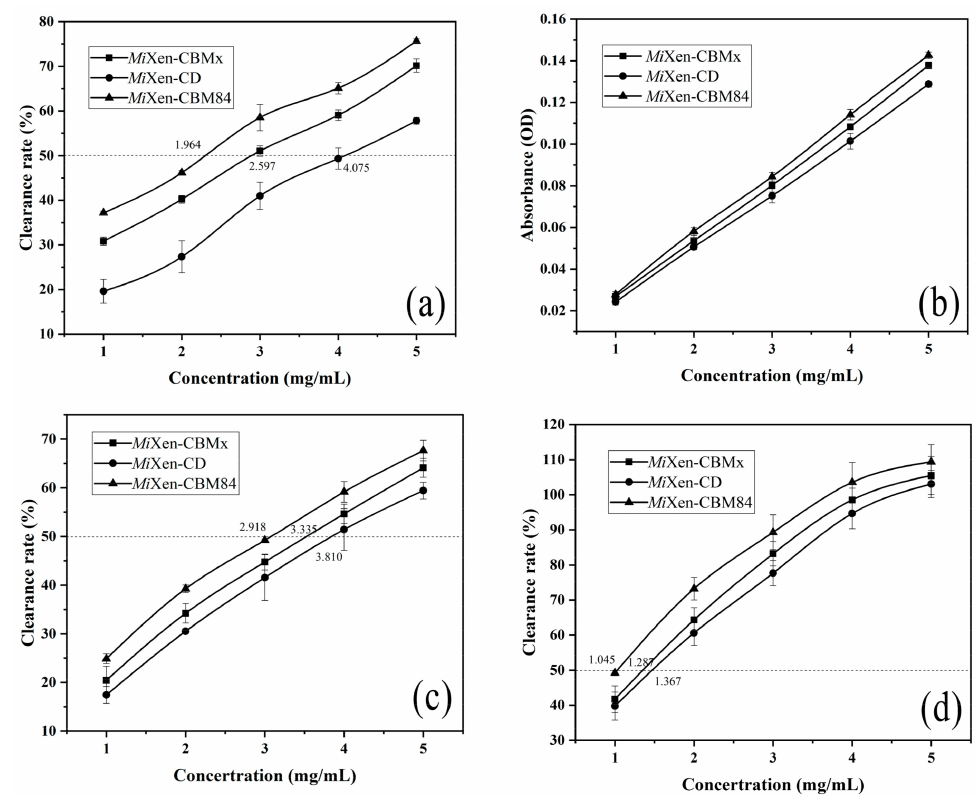
Figure 9. Evaluation of antioxidant properties of xanthan digests prepared by using Mi Xen-CD ( • ), Mi Xen–CBMx ( (cid:4) ), or Mi Xen–CBM84 ( (cid:78) ). ( a ) Ferrous ion chelating activity of xanthan digests. ( b ) 1,1- Diphenyl-2-picrylhydrazyl (DPPH) radical scavenging activity of xanthan digests. ( c ) Hydroxyl radical scavenging activity of xanthan digests. ( d ) Reducing power of xanthan